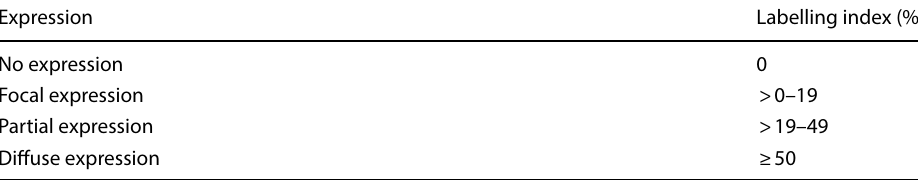
Table 2 Quantitative expression of CD204 + TAMs, CD4 + TILs, and Iba1 + Microglia immunostaining using labelling